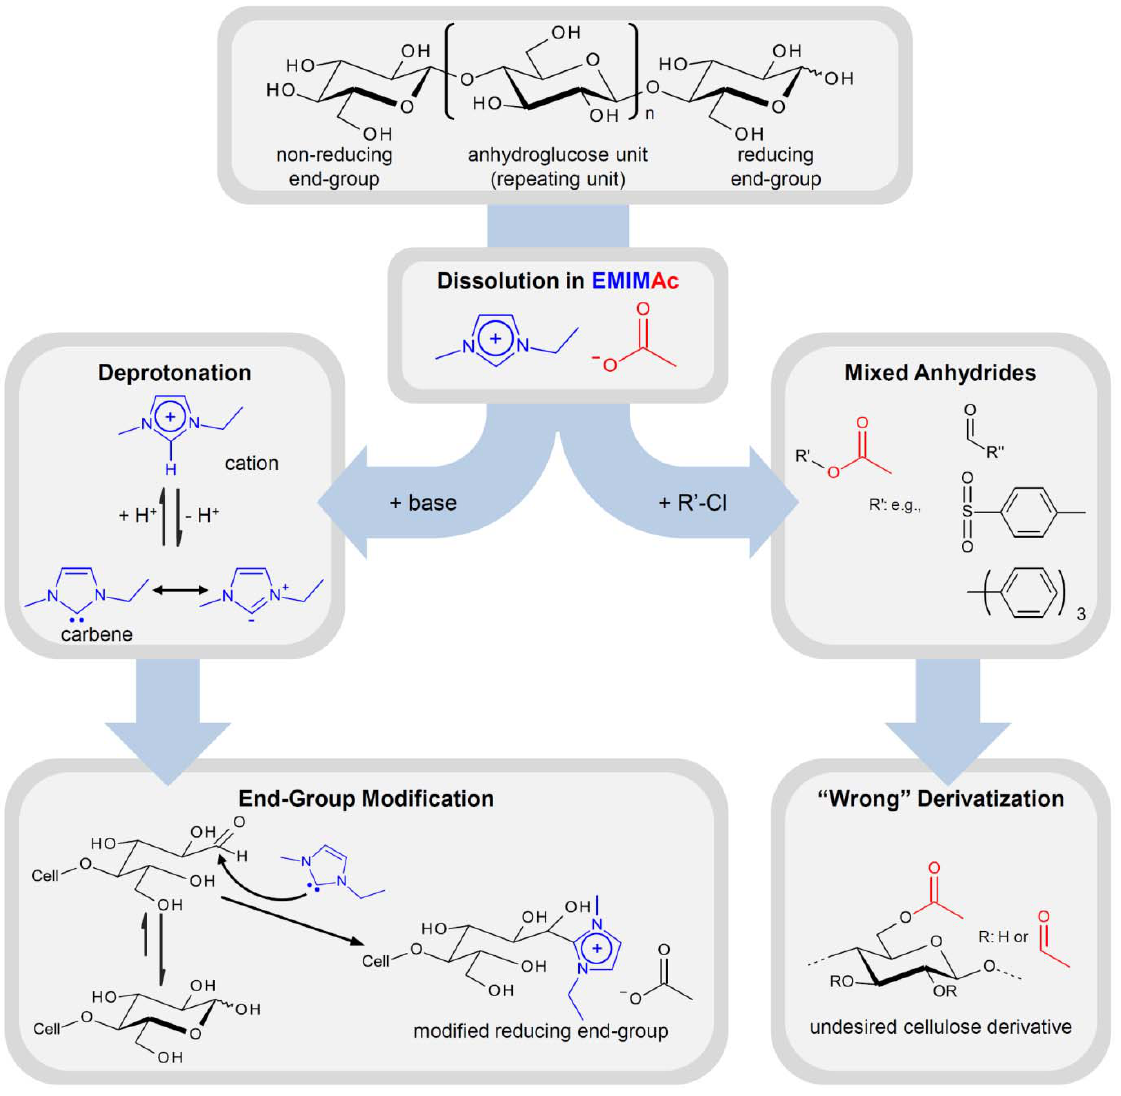
Figure 4. Schematic representation of side reactions, observed upon the dissolution and chemical derivatization of cellulose in 1-ethyl-3-methylimidazolium acetate